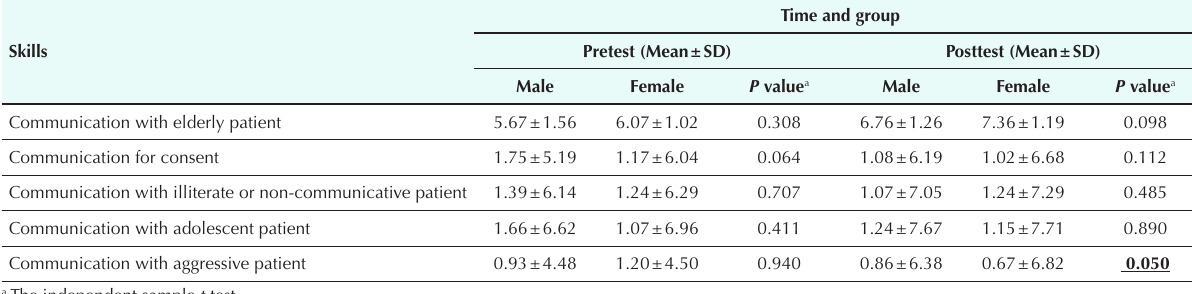
Communication with elderly patient Communication for consent Communication with illiterate or non- communicative patient Communication with adolescent patient Communication with aggressive patient Table 4. Comparisons of male and female participants respecting the mean scores of CSs